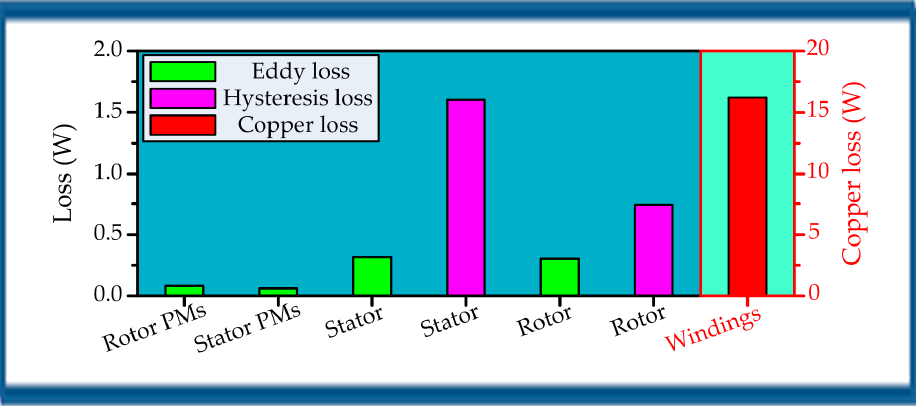
Figure 14. Loss when the proposed machine rotates at 120 r/min ( I = 3 A).